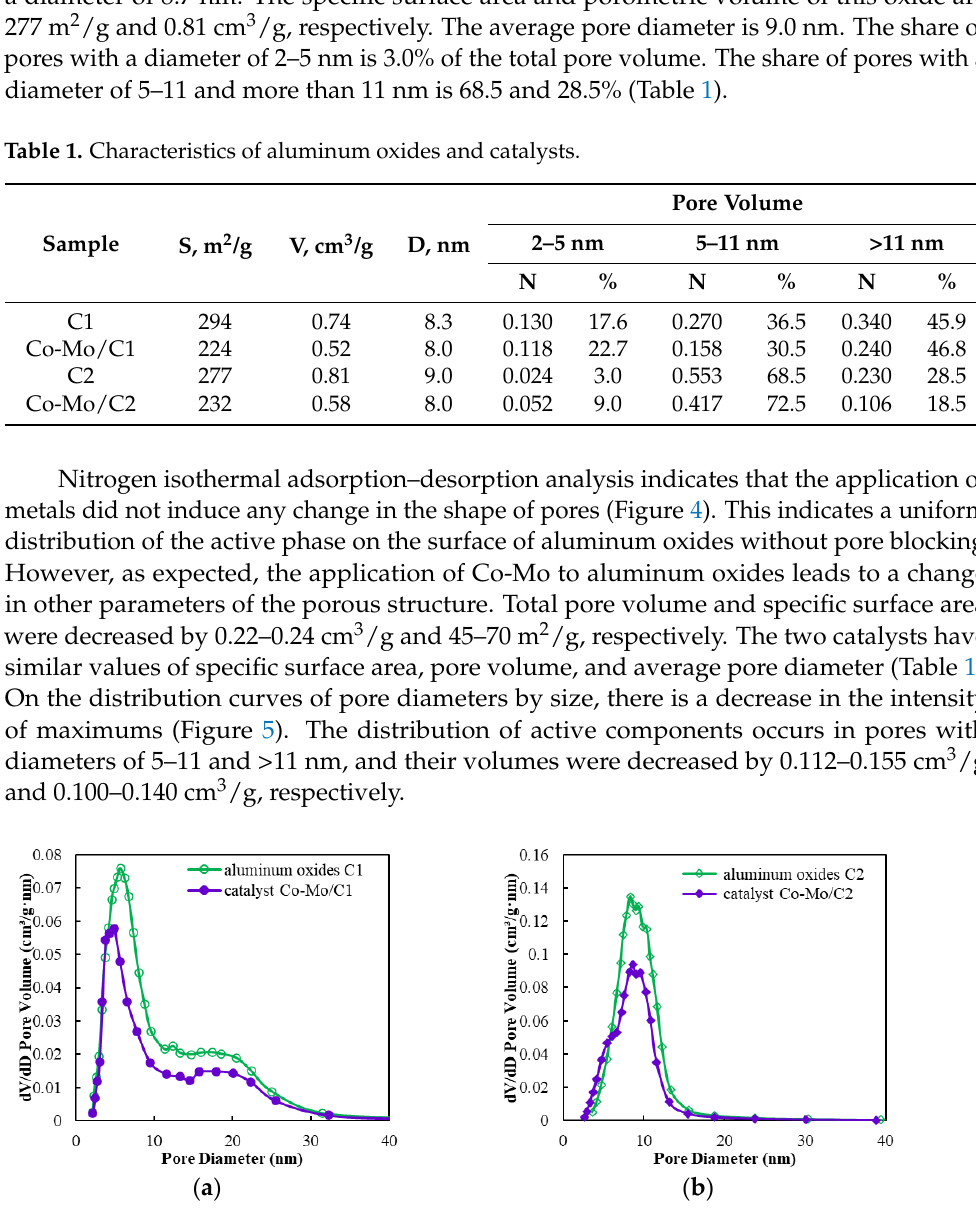
Figure 5. ( a ) Pore size distribution for aluminum oxides C 1 and catalysts. ( b ) Pore size distribution for aluminum oxides C 2 and catalysts.